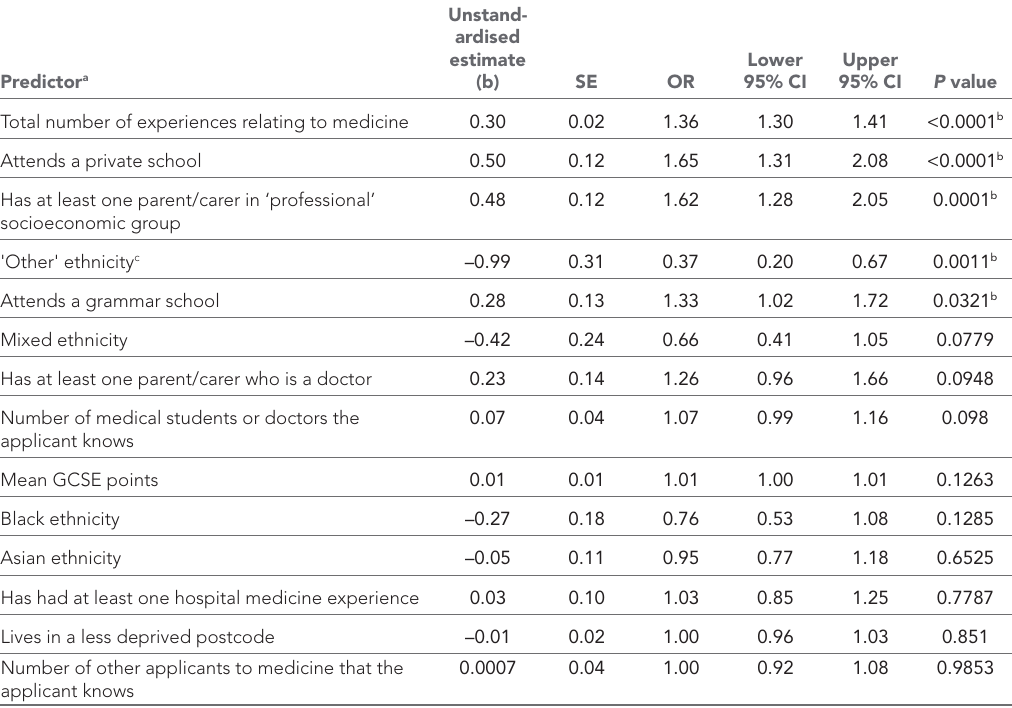
Table 2 Predictors of having at least one GP experience (pooled results from 10 multiple imputa- tions). Predictors ordered by significance